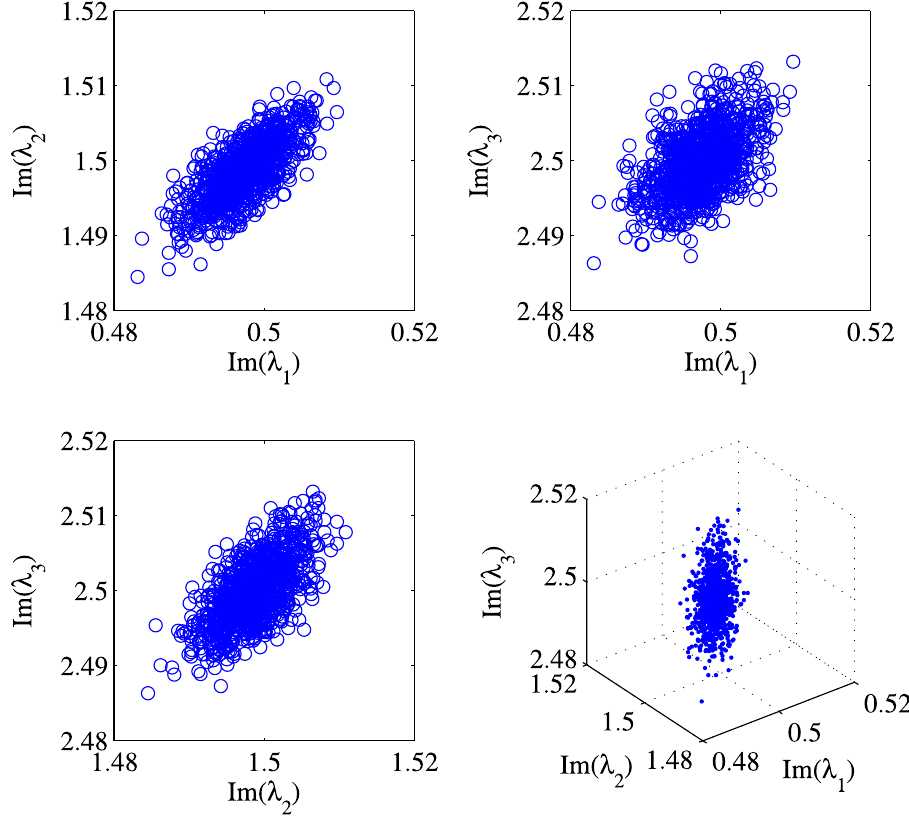
Figure 4. Correlations between all possible pairs of eigenvalues for a 3-eigenvalue input signal. The bottom right figure shows correlation of all eigenvalues in 3 dimensional parameter